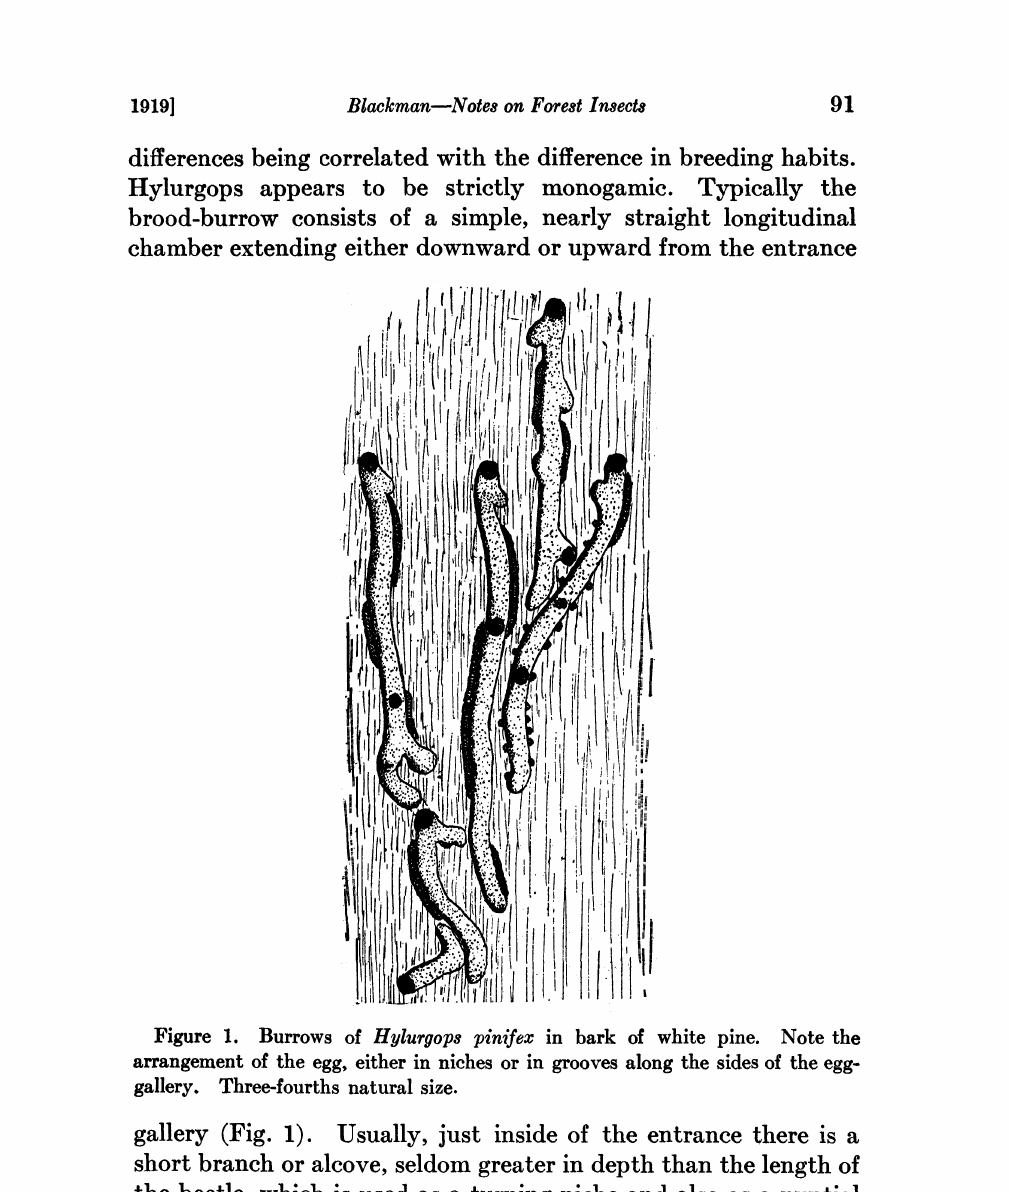
Figure 1. Burrows of Hylurops pinifex in bark of white pine. Note the arrangement of the egg, either in niches or in grooves along the sides of the egg- gallery. Three-fourths natural